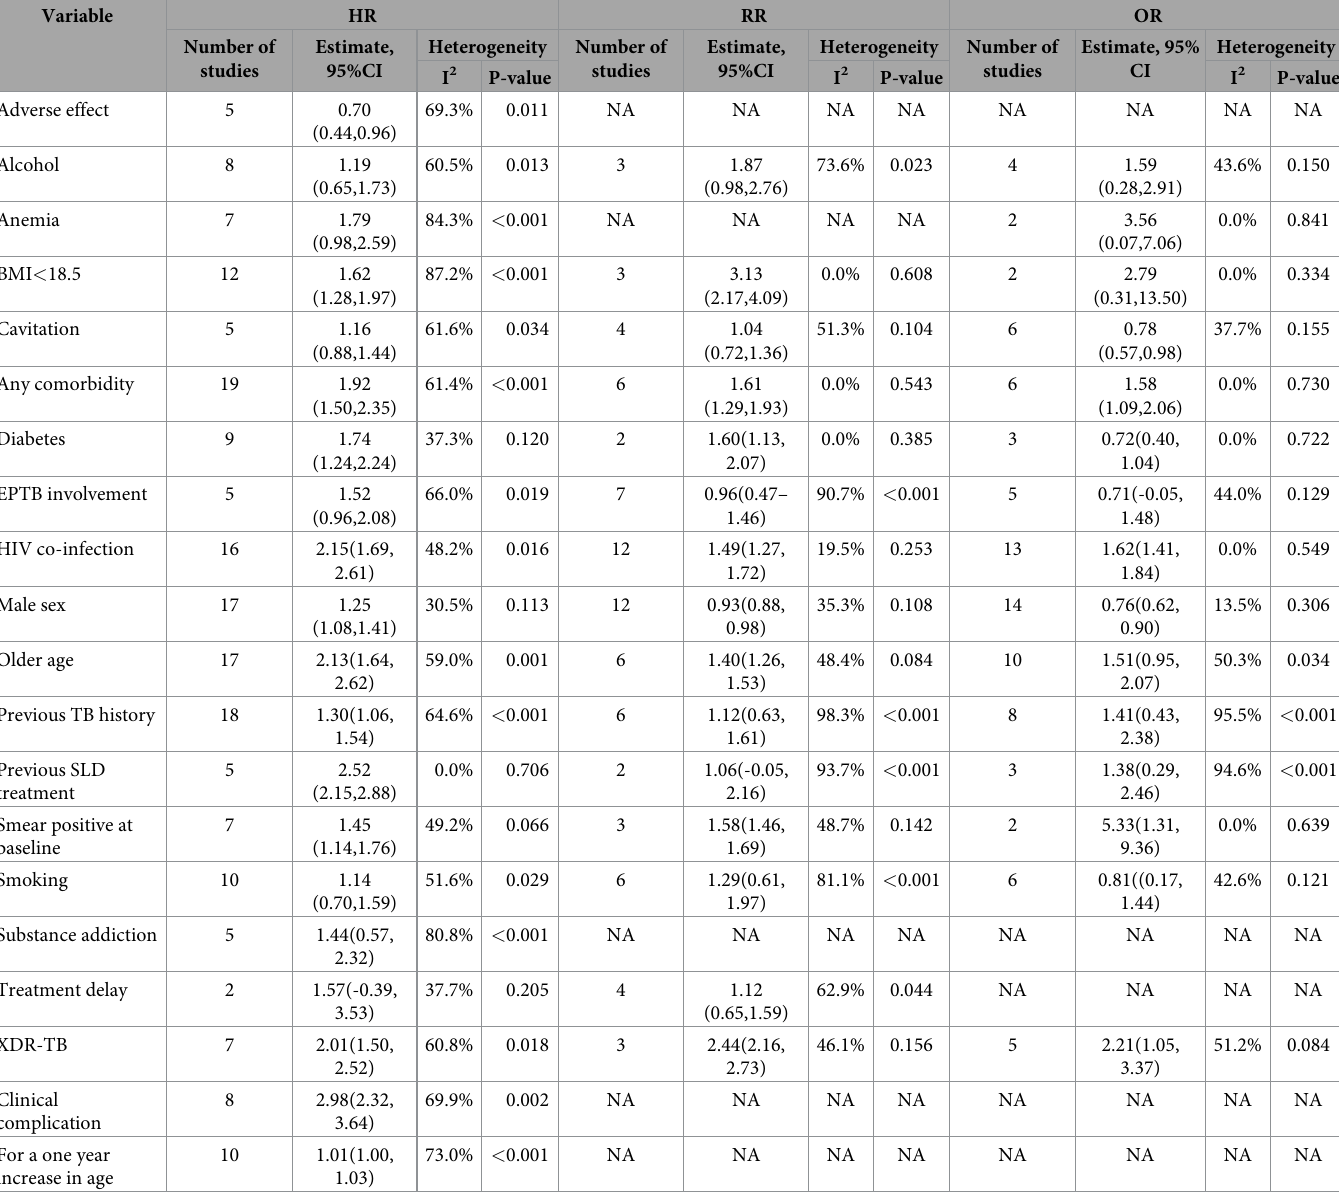
Table 2. The summary of the pooled estimates of the HR, RR, and OR per predicting factors of mortality in patients with drug-resistant tuberculosis.